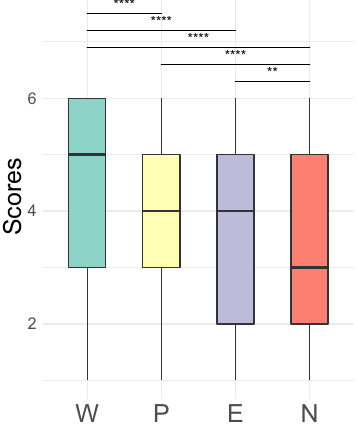
Figure 5. Adult behavioral experiment. The distribution of the scores for all trials and participants are represented per condition. Asterisks represent p-values of the comparisons done two by two (Tuckey tests) *** < 0.001, ** < 0.01. W = Words ( A i B i C i ), P = Part-Words ( B i C i A k ), E = Edge-Words ( A i B i C k ), N = Non-words ( B i C i A i